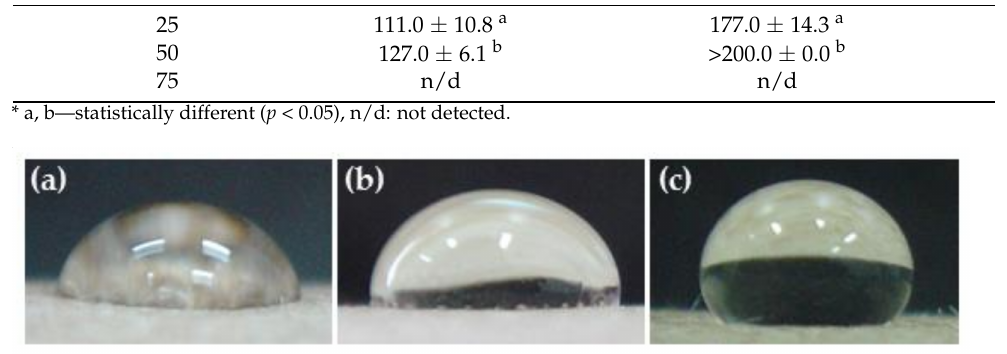
Figure 4. Effect of radio frequency (Watts) on water droplets placed (40 µ L) at 200 mTorr for 5 min with ( a ) untreated, ( b ) 25 Watts, and ( c ) 50